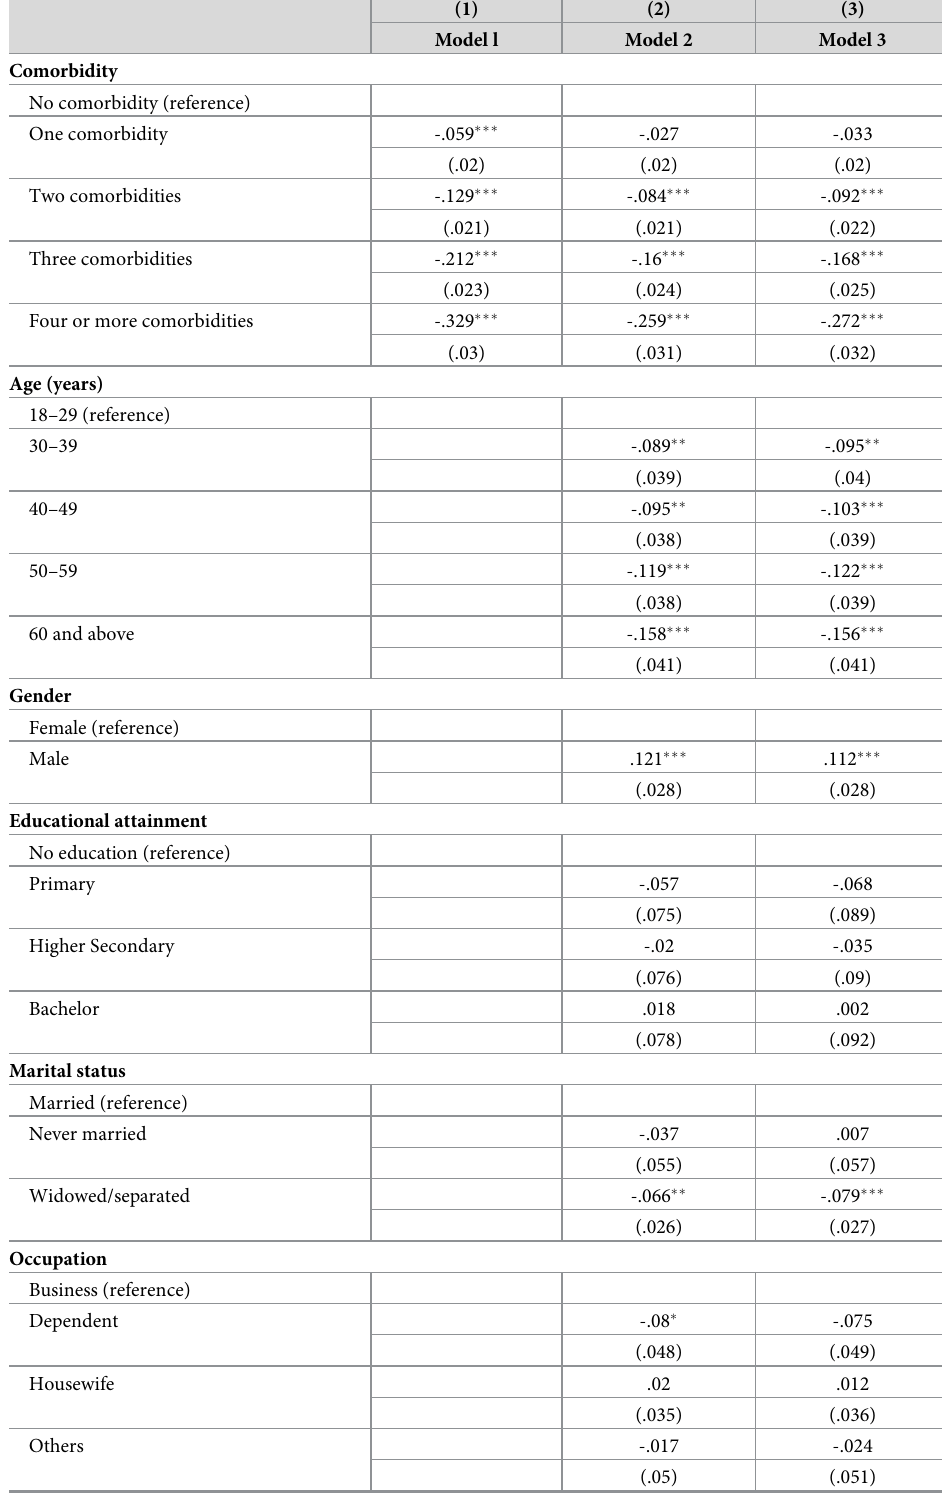
Table 3. Predictors of health-related quality of